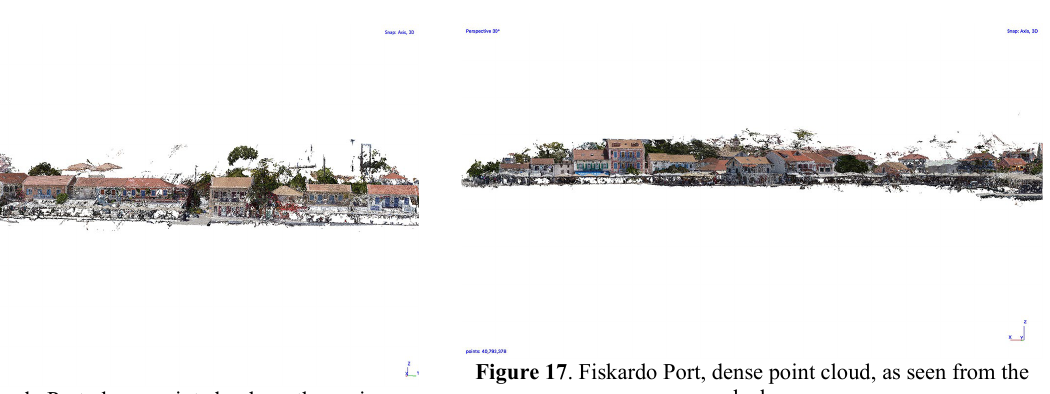
Figure 17 . Fiskardo Port, dense point cloud, as seen from the dock.